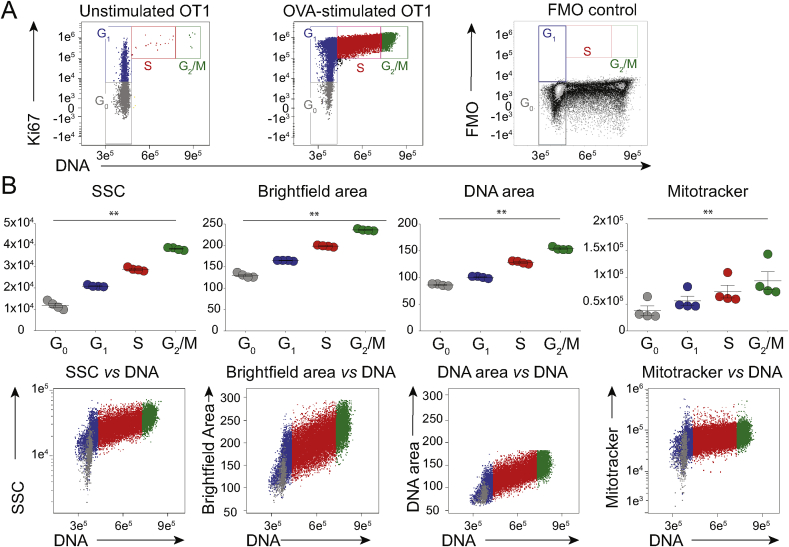
OT-I CD8+ T cells have increased signal for SSC, DNA and mitochondria as they cycle in response to antigen.OT1 LN cells were stimulated with antigen in vitro, and analysed by ImageStream. A) DNA/Ki67 flow cytometry plots of OT1 LN CD8+ cells either unstimulated (left), or stimulated with OVA 257–264 peptide (centre), with Ki67 FMO plot of stimulated CD8+ cells (right). Gates for G0, G1, S and G2/M are indicated. B) Median SSC (arbitrary units), Brightfield (μm2), and DNA image area (μm2), and Mitotracker Intensity (arbitrary units) of CD8+ cells in G0, G1, S and G2/M, gated as in A (top, N = 4 experiments). Bivariate DNA intensity (arbitrary units) plots from a representative experiment (bottom, colour code as in A). Statistical analysis performed using Friedman's test with Dunn's multiple comparison tests.